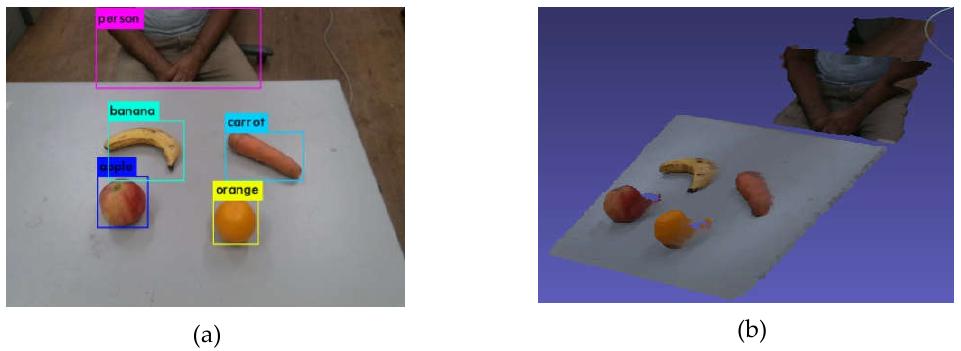
Figure 6. ( a ) Example of object recognition from RGB image, and ( b ) three-dimensional (3D) image Figure 6. (a) Example of object recognition from RGB image, and (b) three-dimensional (3D) image transformed from depth data to the table surface plane. transformed from depth data to the table surface plane.